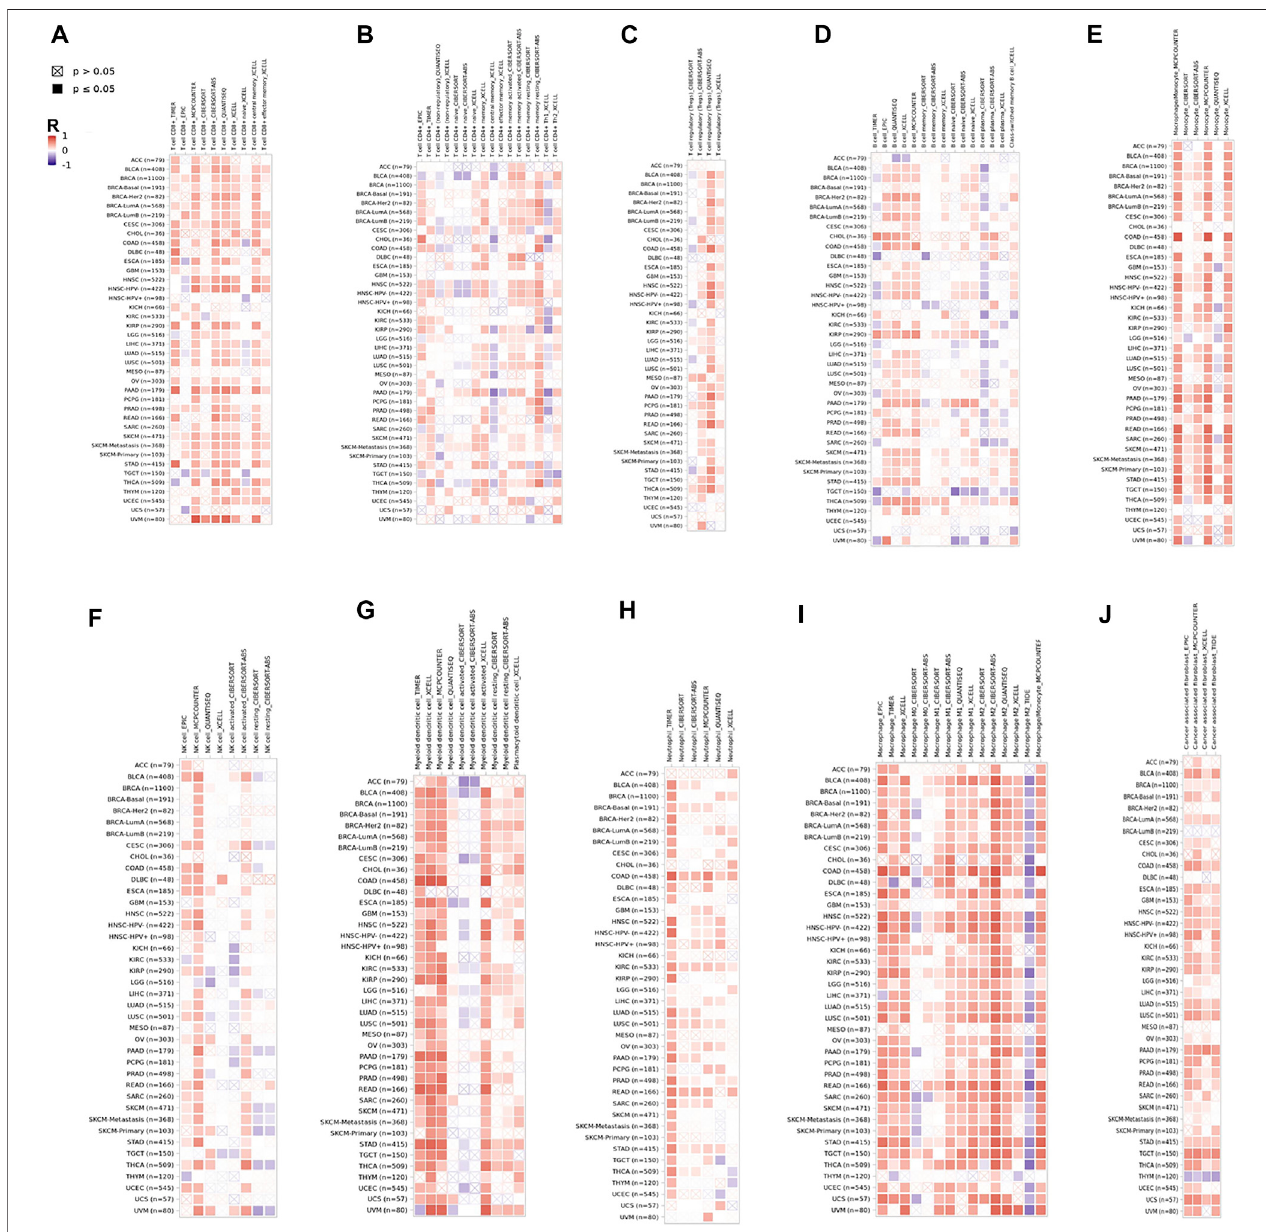
FIGURE 5| CD209correlates with the in fi ltration of innate and adaptive immune cells in various cancer types. Correlation ofCD209 with (A) the in fi ltration of CD8 + T cells, (B) CD4 + T cells, (C) Treg cells, ( D) B cells, (E) monocytes cells, (F) NK cells, (G) dendritic cells, (H) neutrophils, (I) macrophages, and (J) cancer-associated fi broblastsinvariouscancertypesanalyzedbyTIMER2afterpurityadjustment.R:Spearman ’ scorrelationcoef fi cient.Spearman ’ sR(red):positivecorrelation, p < 0.05,r > 0; Spearman ’ s R (blue): negative correlation, p < 0.05, r < 0.